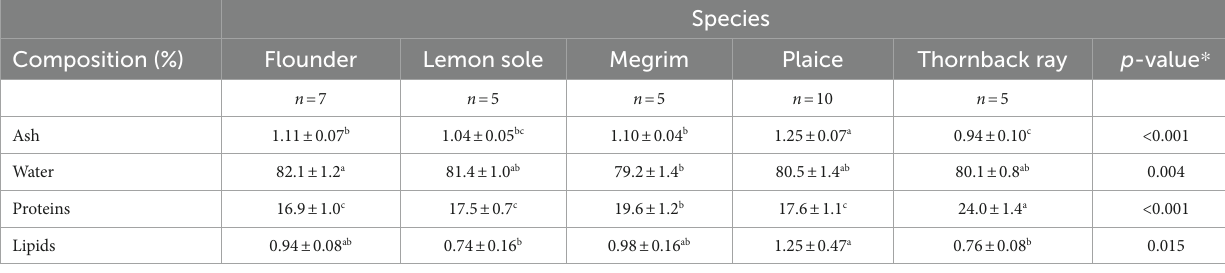
TABLE 1 Proximate composition of central fillets of flounder, lemon sole, megrim, plaice, and thornback